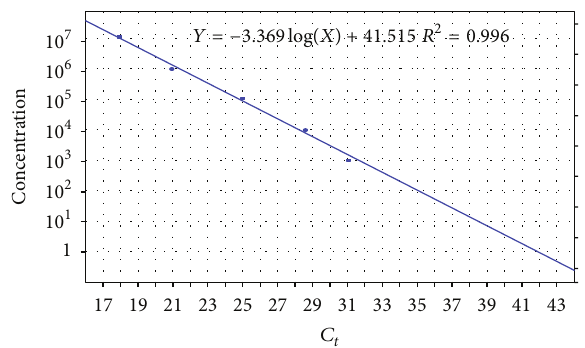
Figure 1: Standard curve. The five standards are 10 3 , 10 4 , 10 5 , 10 6 , and 10 7